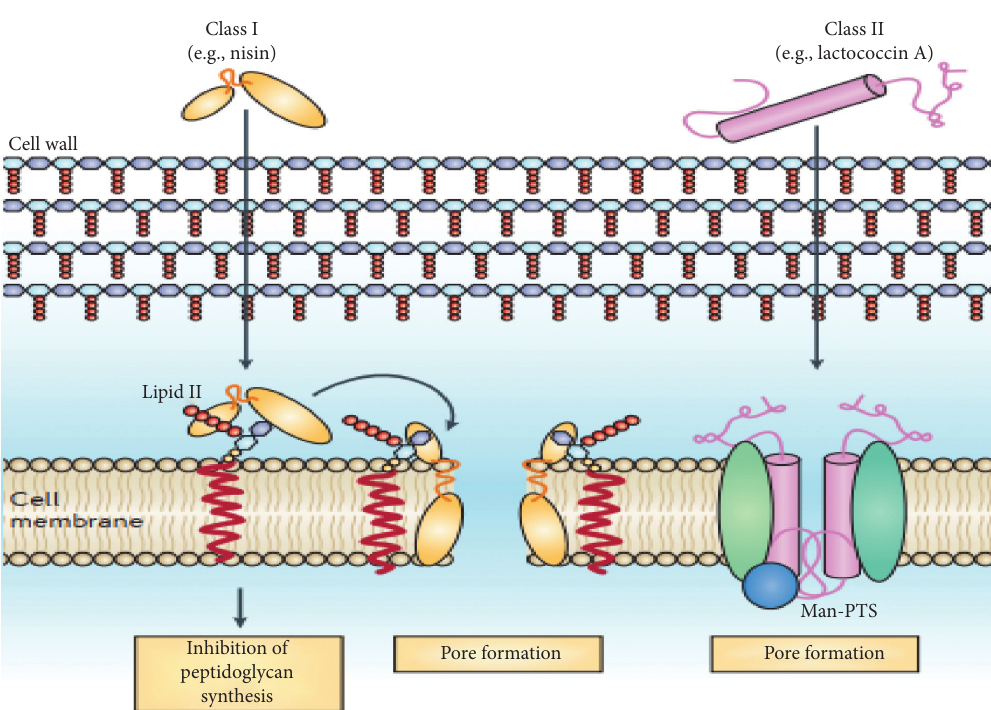
Figure 1: Mechanism of action of bacteriocins on Gram-positive bacteria [16].